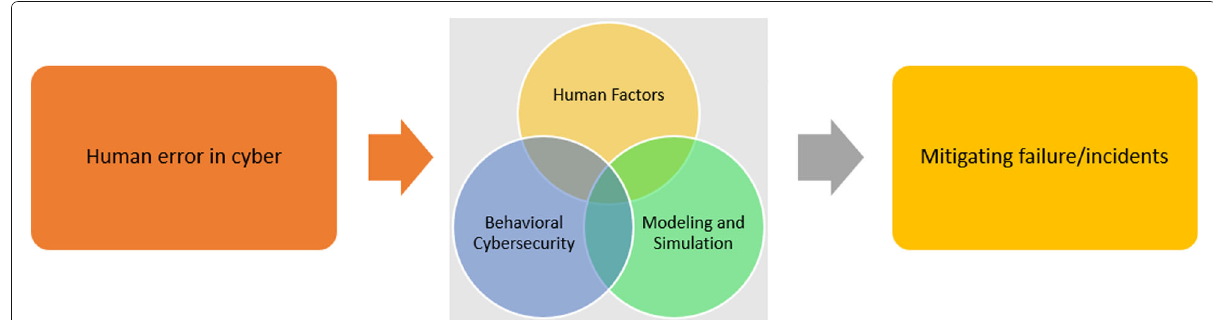
Fig. 7 Mitigating human error concept model using proposed